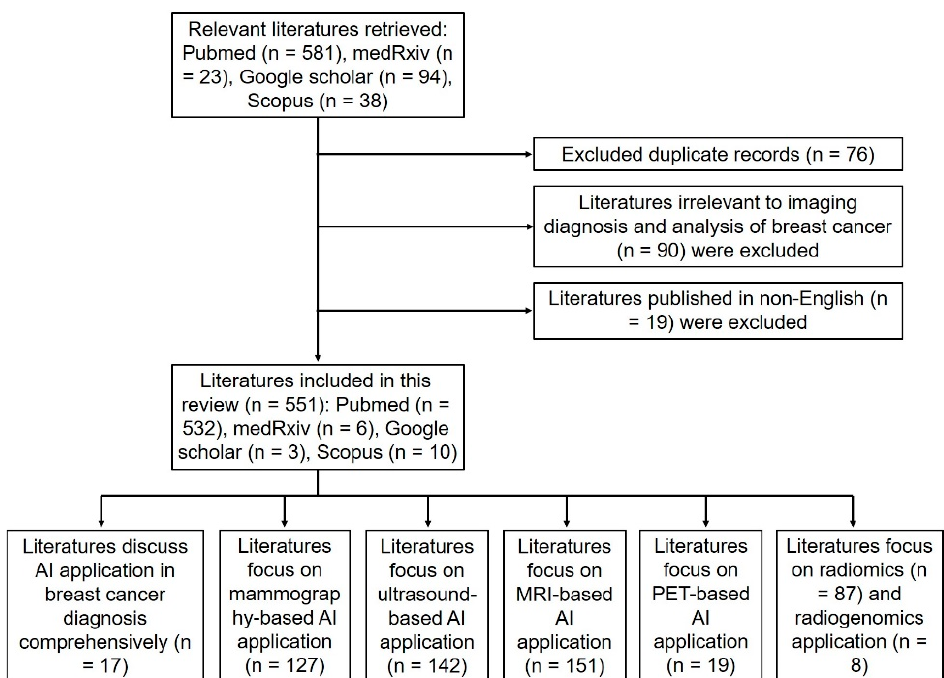
Figure 1. Flowchart to indicate the literature screening